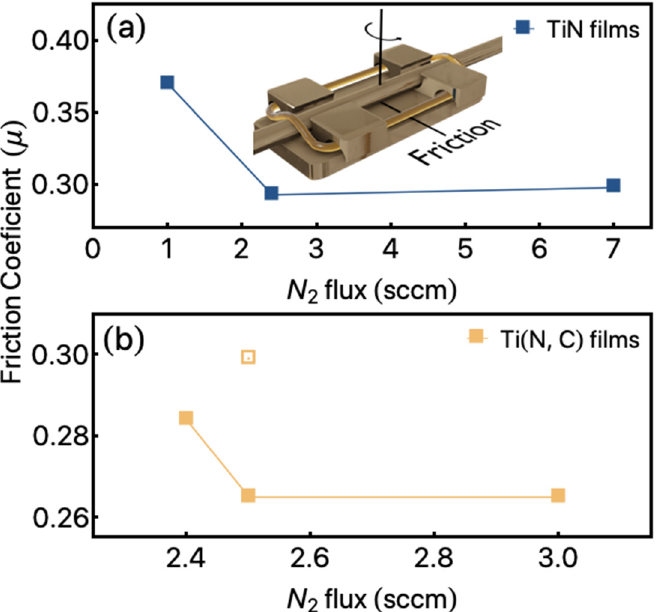
Figure 4. Friction coefficient as a function of N 2 gas flow for the studied films. ( a ) Results were observed for the TiN films. The inset shows a characteristic bracket and the respective wire indicating the friction in the real system. ( b ) Results were obtained for Ti (N, C) films. Especially the substrate tested in identical conditions presented μ = 0.91. The open symbol shows the results observed for the Ti (N, C) film in which 132 mm 2 of C pallets were used.